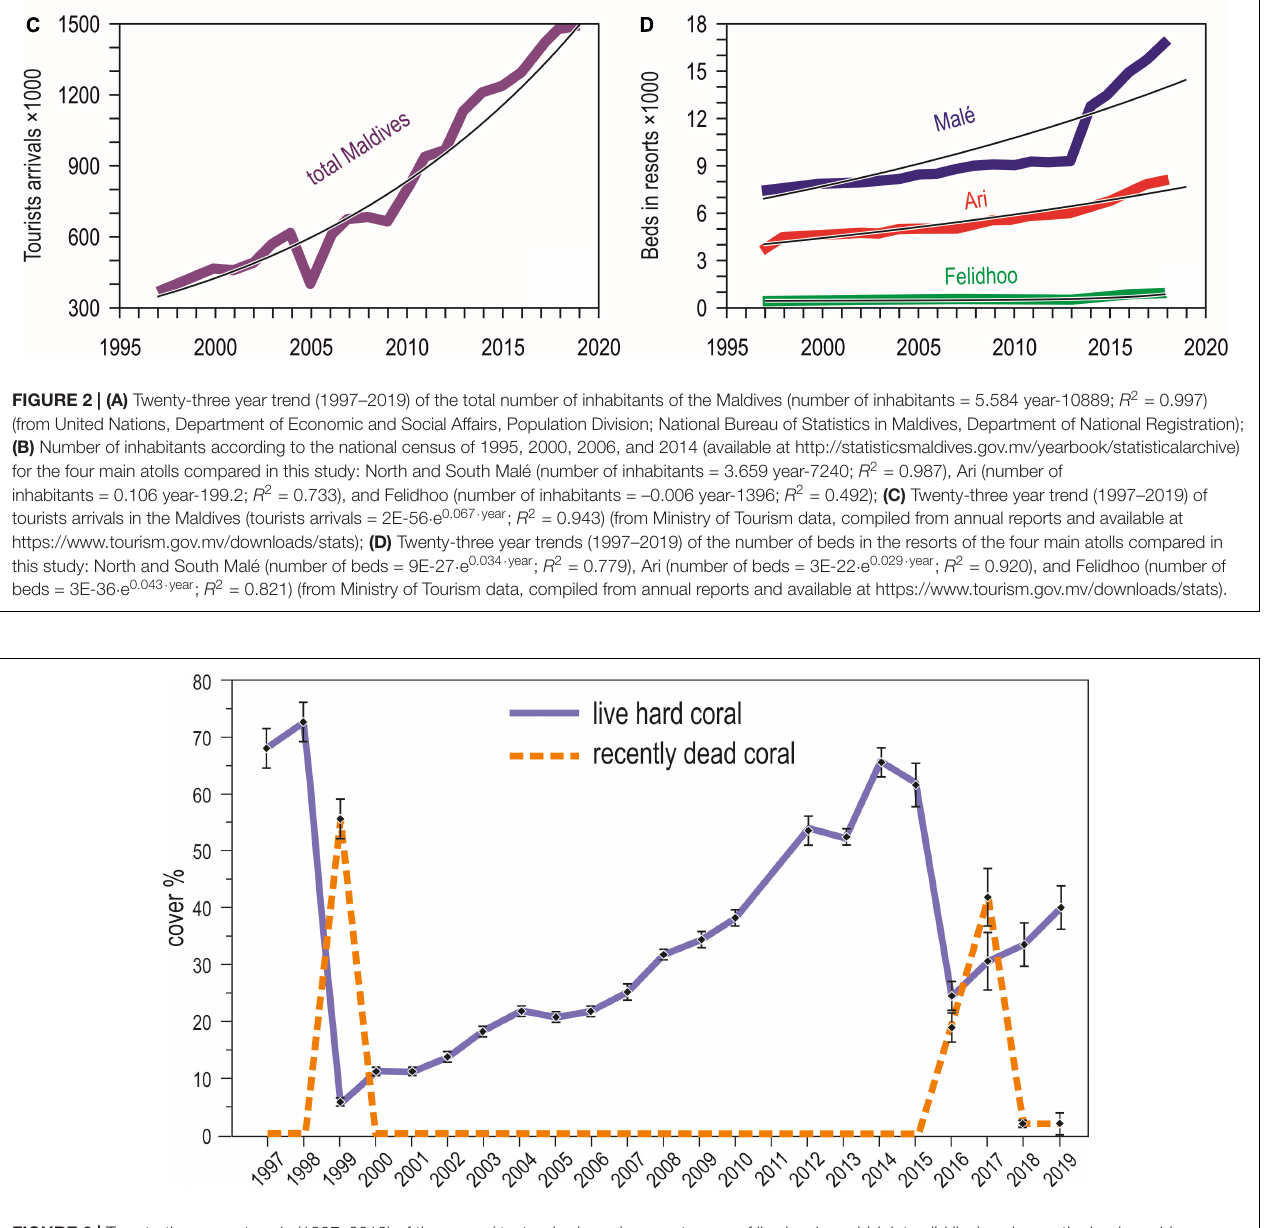
Frontiers in Marine Science |